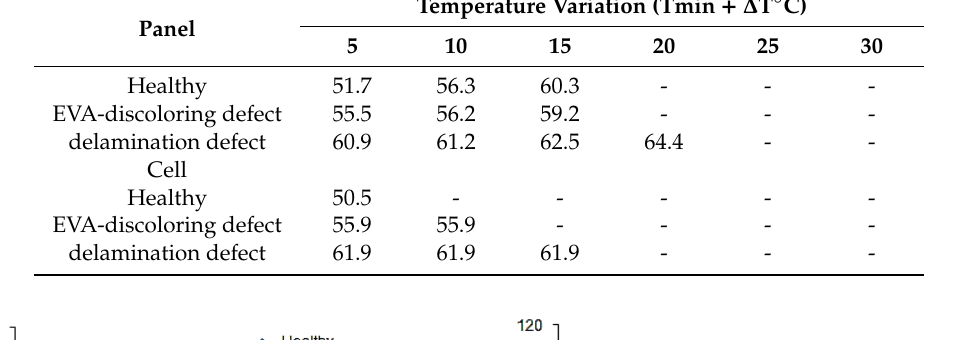
Table 6. Average temperature matrix of the thermal image of the panel and cell.